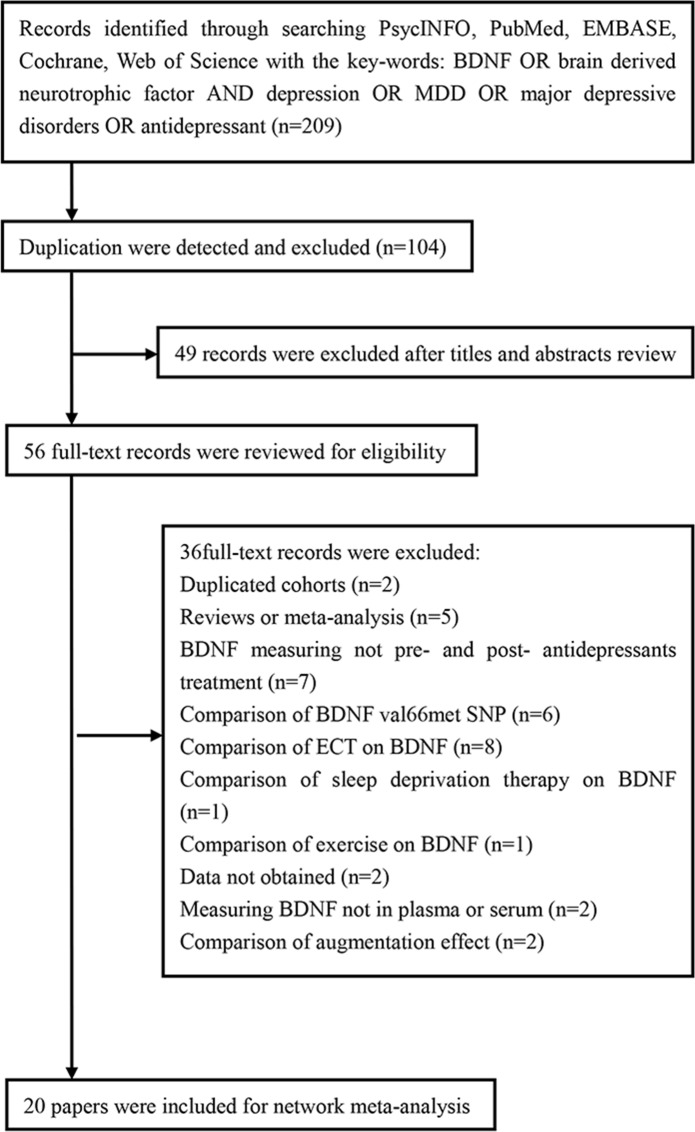
Flowchart of Study Selection.